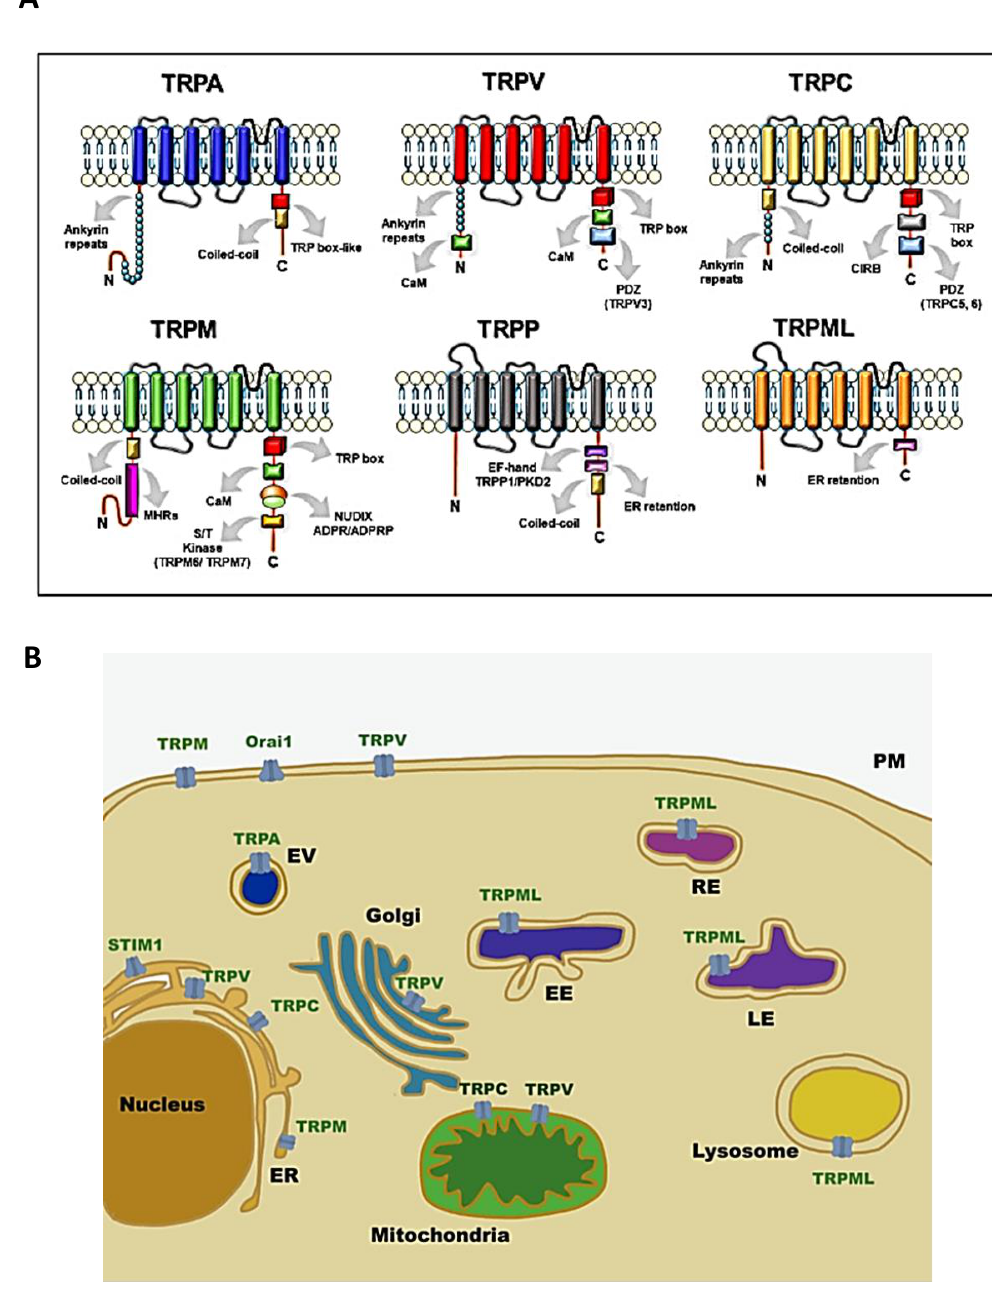
Figure 1. Structure and localisation of TRP channels: ( A ) structural domains and motifs in the N- and C- terminus of TRP channel subfamilies [7]; ( B ) intracellular localisation of TRP channel subfamilies and SOCE machinery. Abbreviations: TRPA, transient receptor potential ankyrin; TRPC, transient receptor potential canonical; TRPM, transient receptor potential melastatin; TRPML, transient receptor potential mucolipidin; TRPP, transient receptor potential polycystic; TRPV, transient receptor potential vanilloid; ER, endoplasmatic reticulum; EV, vesicle of exocytosis; EE, early endosome; RE, recycling endosome; LE, late endosome; PM, plasma membrane; STIM1, stromal interaction molecule 1; Orai1, calcium release-activated calcium channel protein 1.